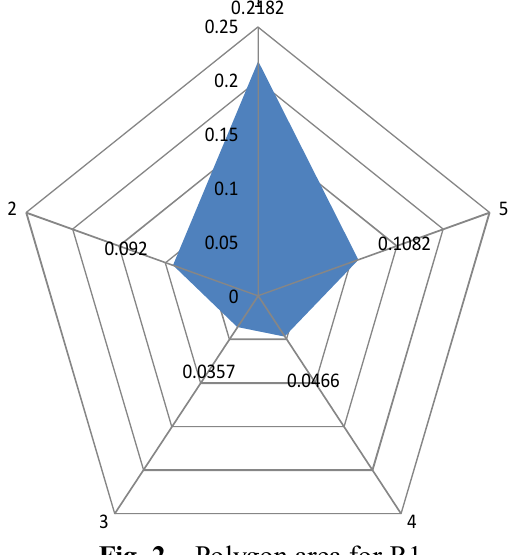
Fig. 2. Polygon area for